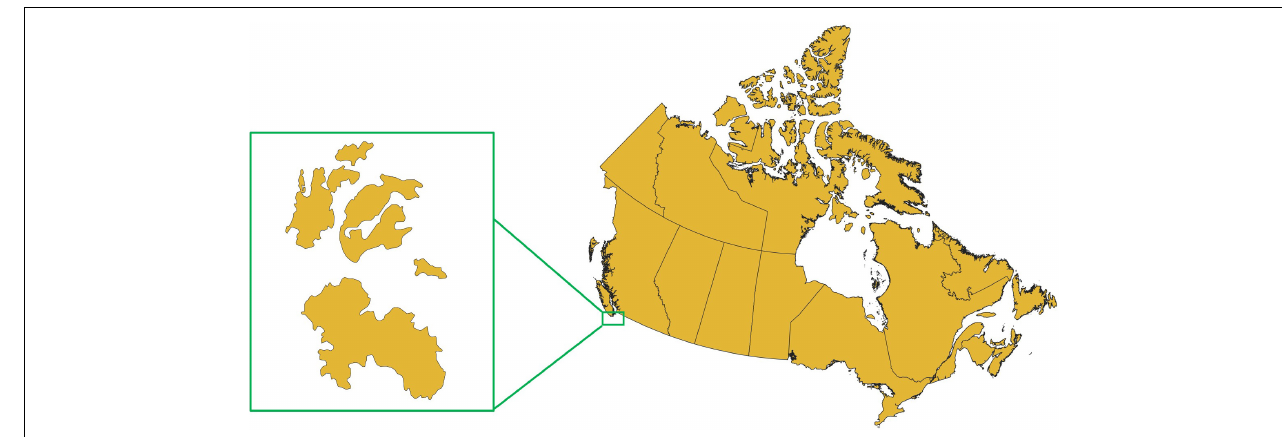
FIGURE 1 | Outline and location of Tl’ches on the British Columbia coast of Canada.